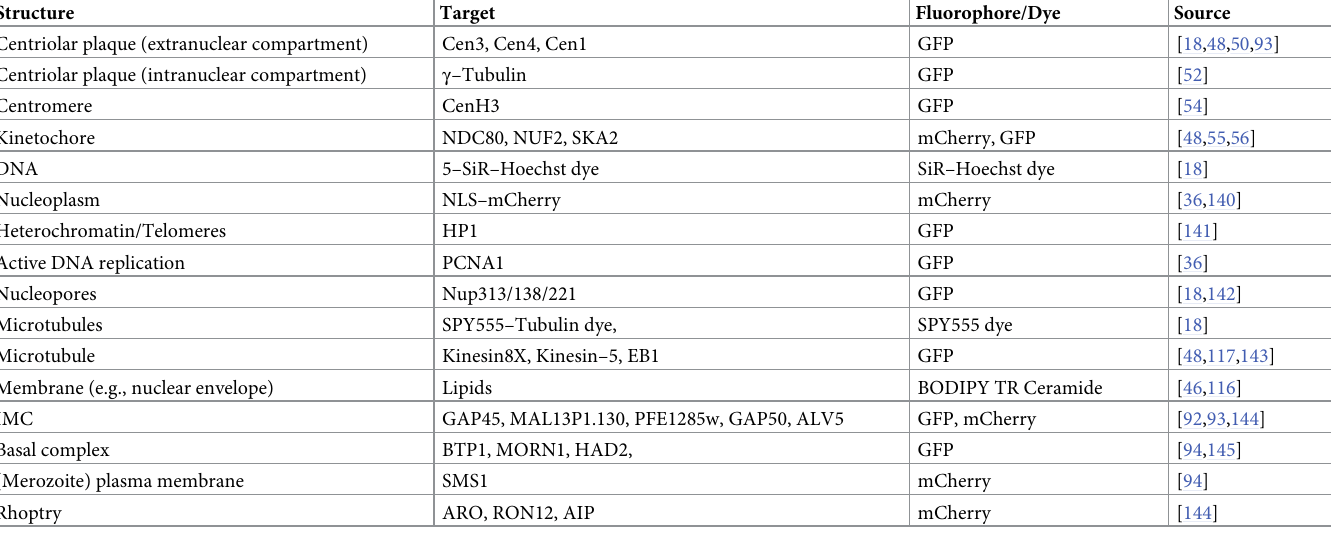
Table 1. Selected marker for live–cell imaging of P . falciparum schizogony in blood stages.